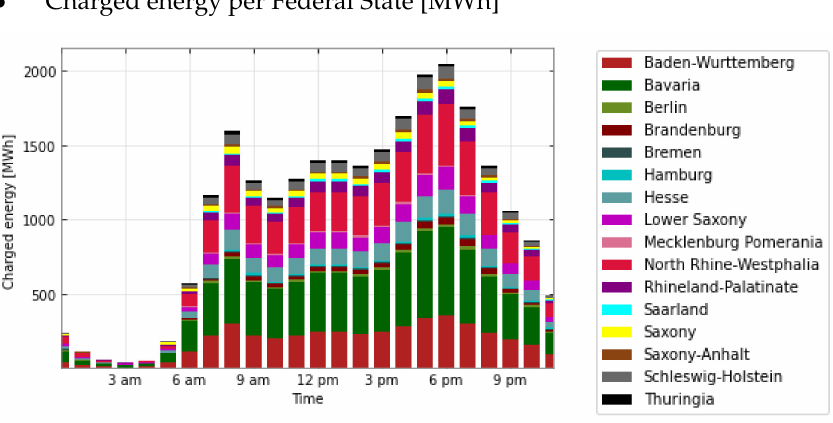
Figure A2. Charged energy of all i3 BEVs per Federal